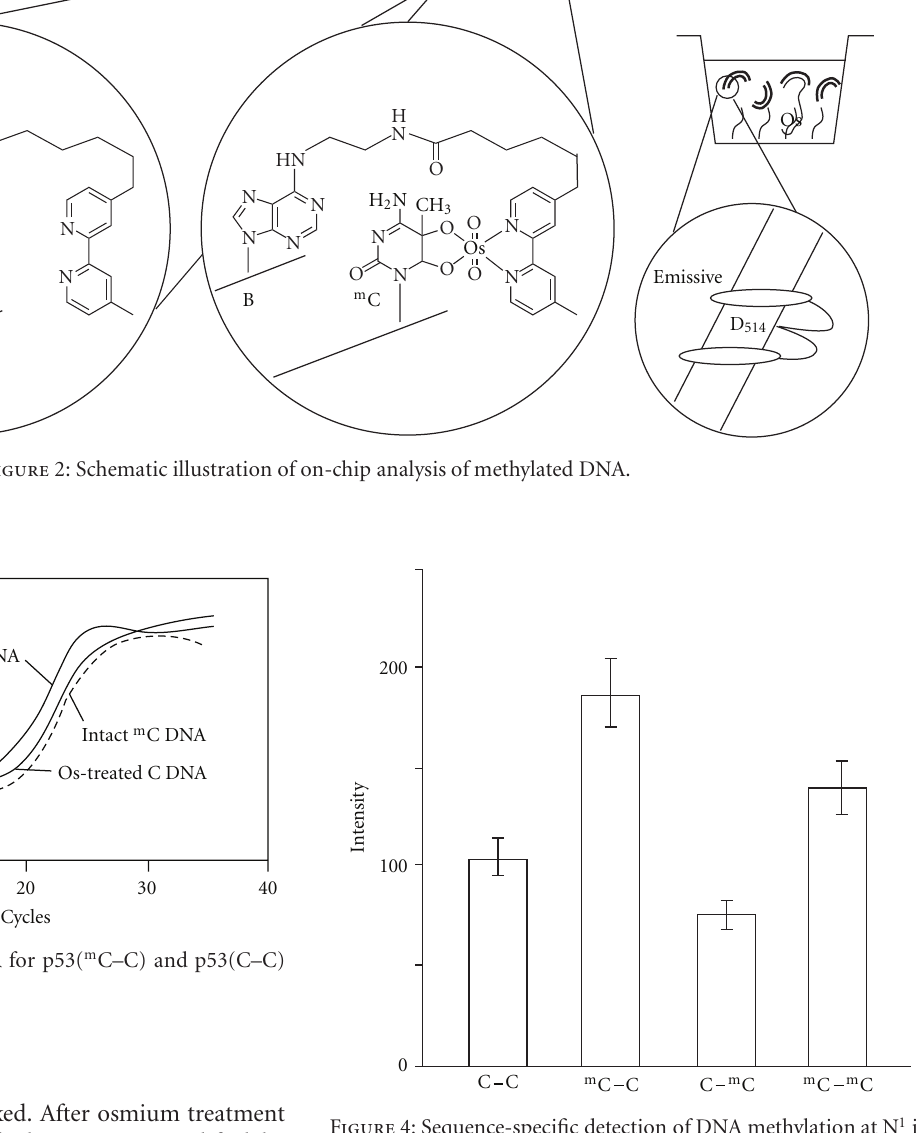
Figure 4: Sequence-specific detection of DNA methylation at N 1 in p53(N 1 –N 2 ) using an ICON